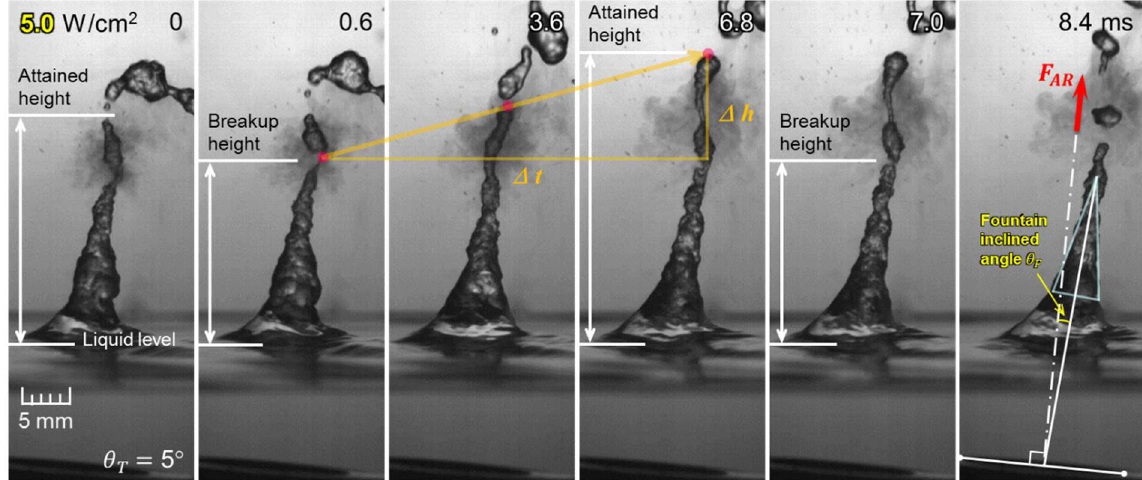
Figure 2. Time course of liquid-fountain dynamics signifying its axial variations, based on the defined fountain’s breakup and attained heights; its lateral fluctuations are specified by θ F (+ θ T